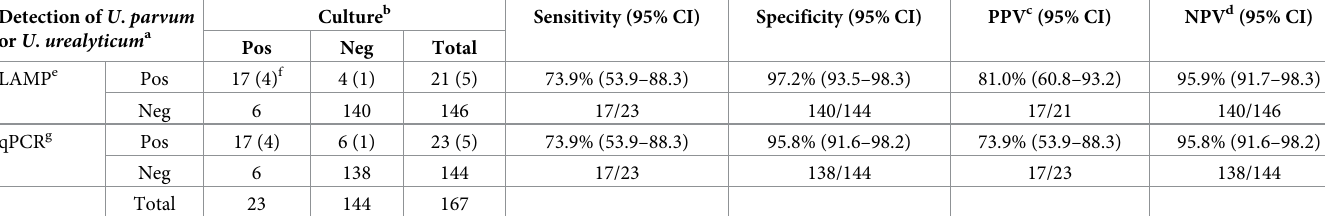
a U . parvum : Ureaplasma parvum , U . urealyticum : Ureaplasma urealyticum .